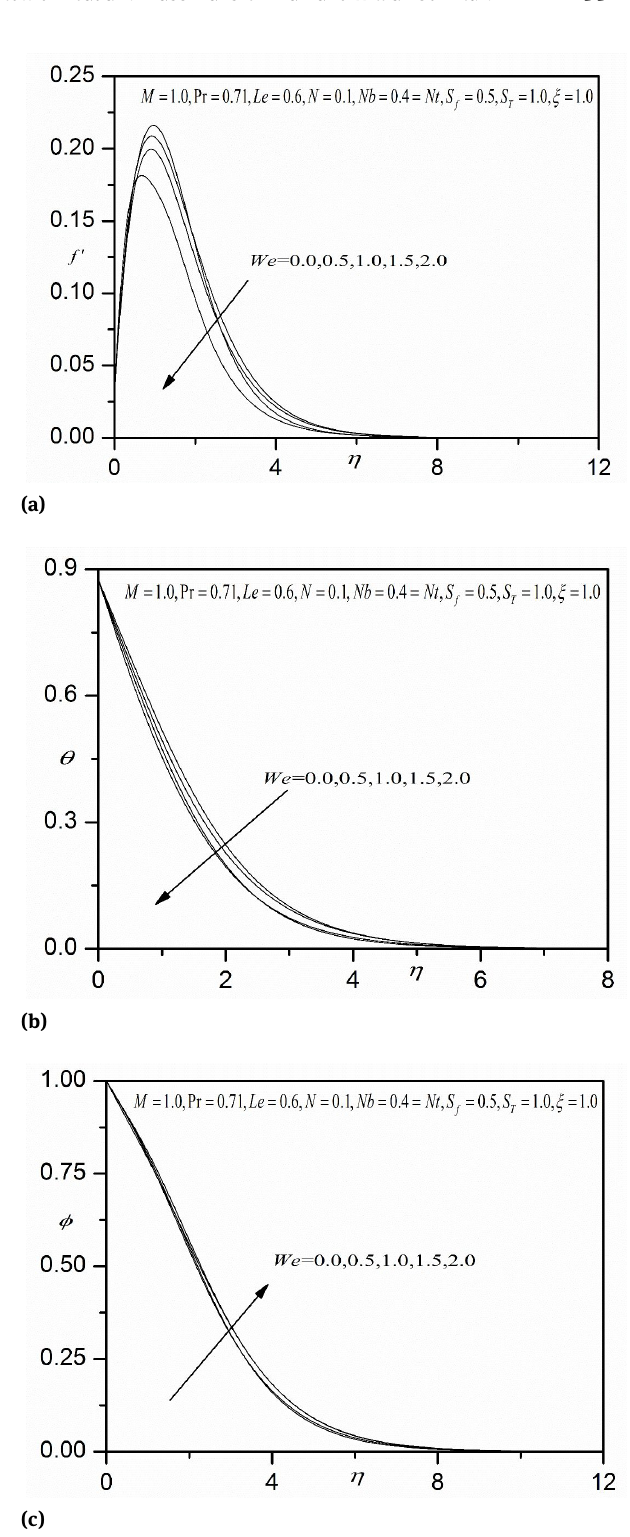
Fig. 3: (a) Effect of We on velocity profile; (b) Effect of We on temper- ature profile; (c) Effect of We on concentration